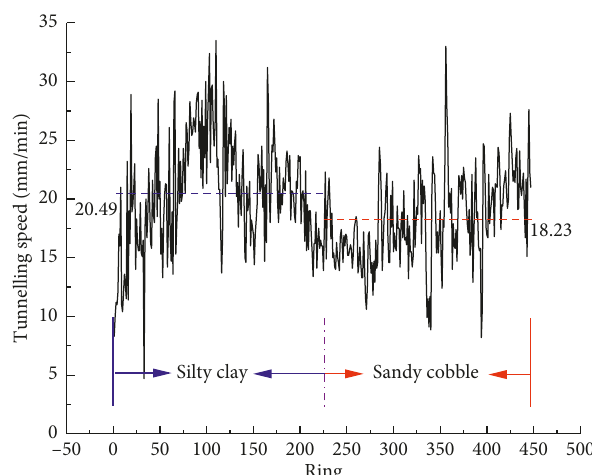
Figure 5: History of shield tunnelling